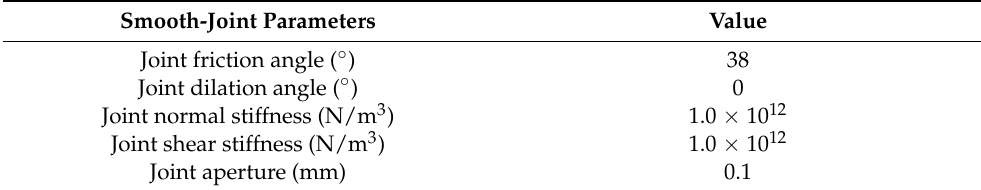
Table 5. Microscopic properties of the smooth-joint contact of a pre-existing